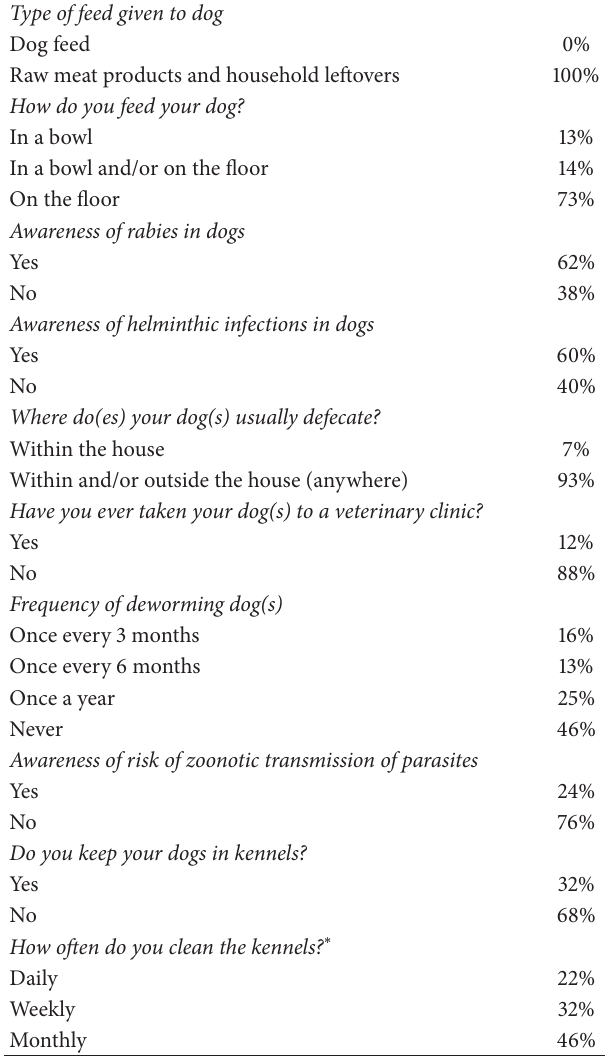
Table 5: Dog management practices and awareness of zoonotic parasites ( 𝑁 = 100